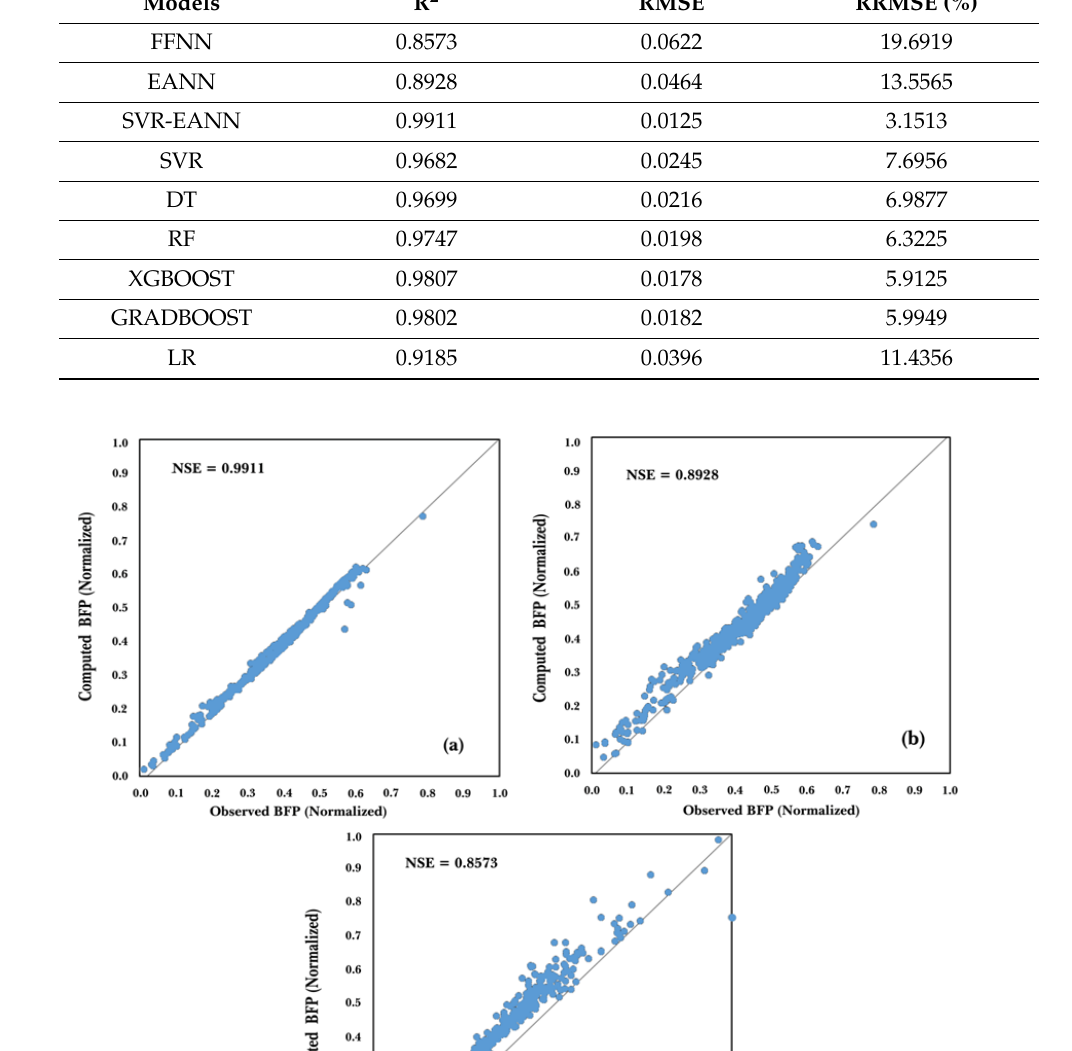
Table 4. BFP prediction results.